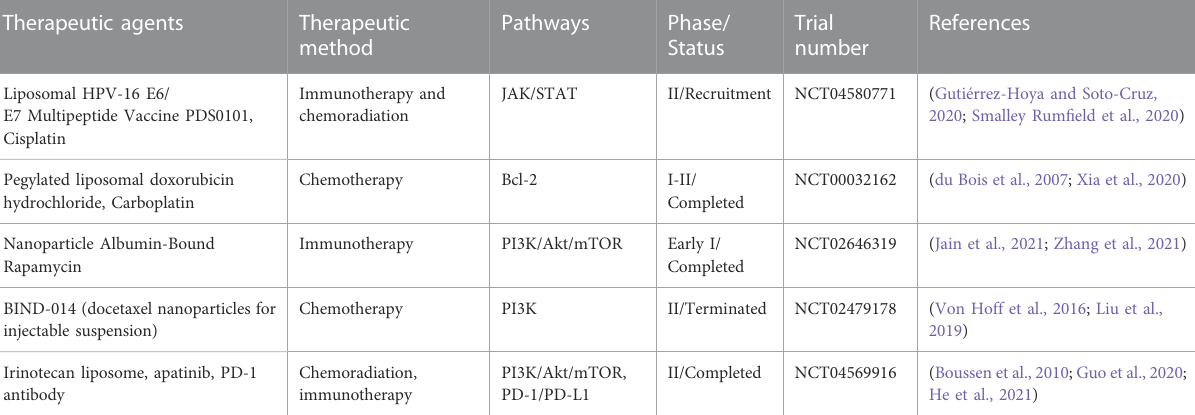
TABLE 2 Clinical application of nanotechnology-based therapy for cervical